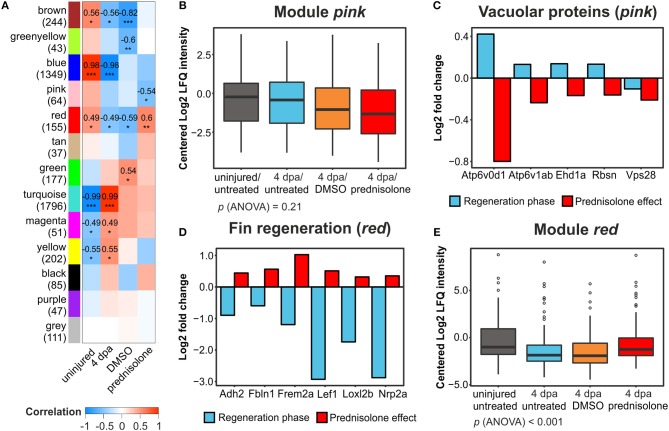
Weighted gene correlation network analysis of all filtered proteins. (A) Module-treatment relationship. Coefficients are indicated for |cor| > 0.4 and p < 0.05 with significance levels *p < 0.05, **p < 0.01, and ***p < 0.001. Numbers in brackets at the module names indicate the number of proteins in the modules. (B) Mean centered log2-transformed intensities of all proteins and treatments from the module pink. (C) Log2-transformed fold changes of 5 vacuolar proteins in the module pink identified from functional annotation analysis. (D) Log2-transformed FC of six proteins involved in fin regeneration and mesenchymal development in the module red identified from functional annotation analysis. (E) Mean centered log2-transformed intensities of all proteins and treatments from the module red.